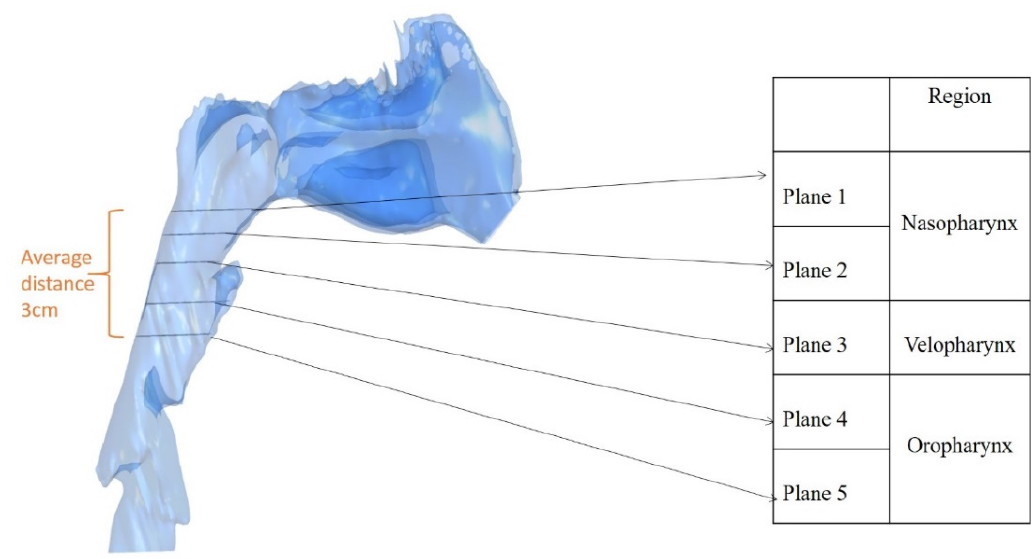
Figure 4. Different planes for the cross-sectional measurement. The boundary of the upper airway was studied between planes 1 and